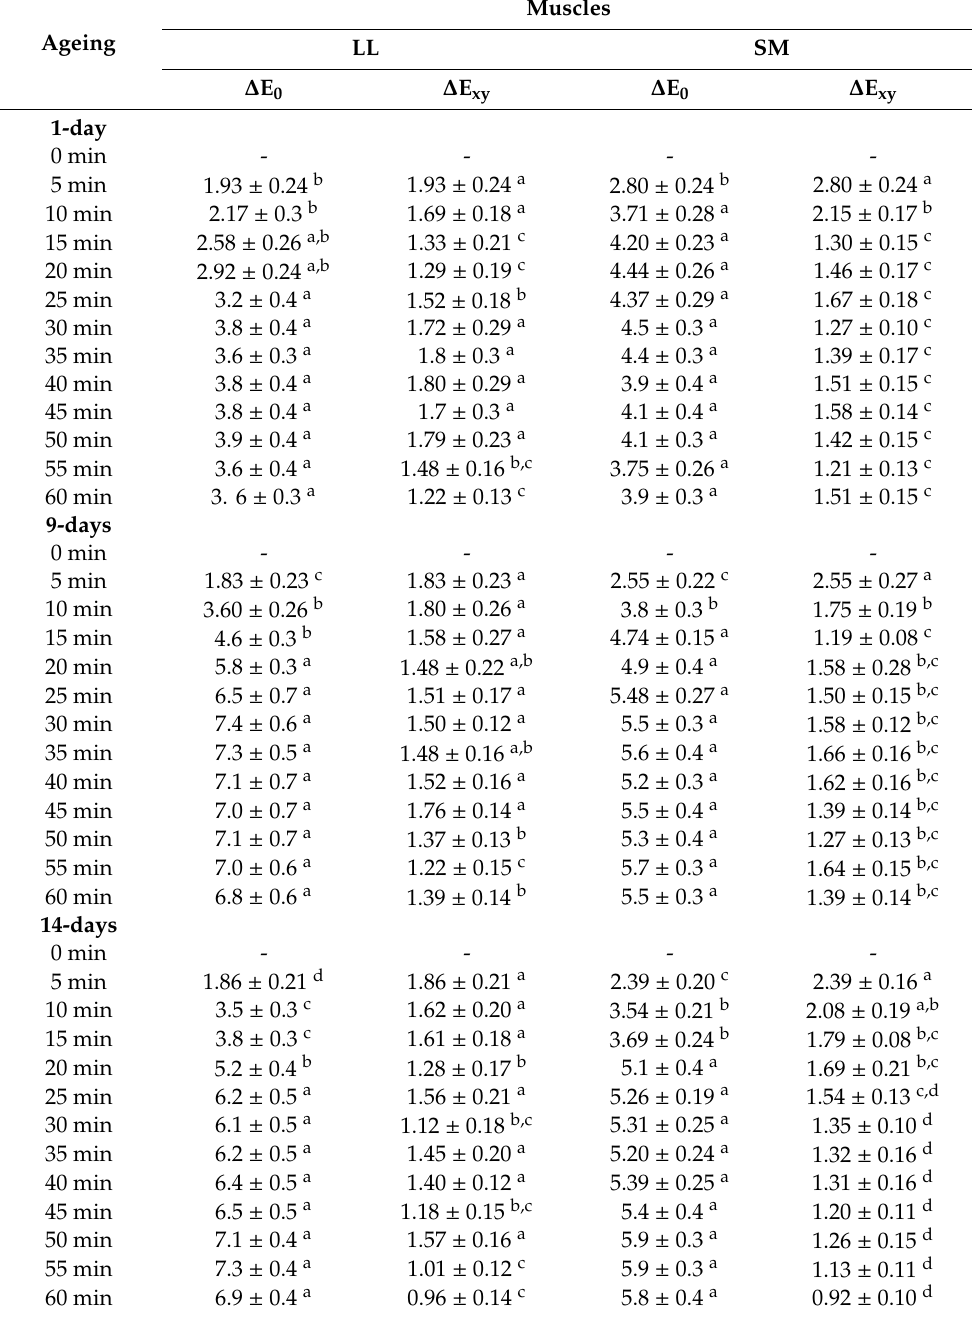
Table 1. Color di ff erences during 60 min blooming in longissimus lumborum (LL, n = 24) and semimembranosus (SM, n = 24) muscles (mean values ±